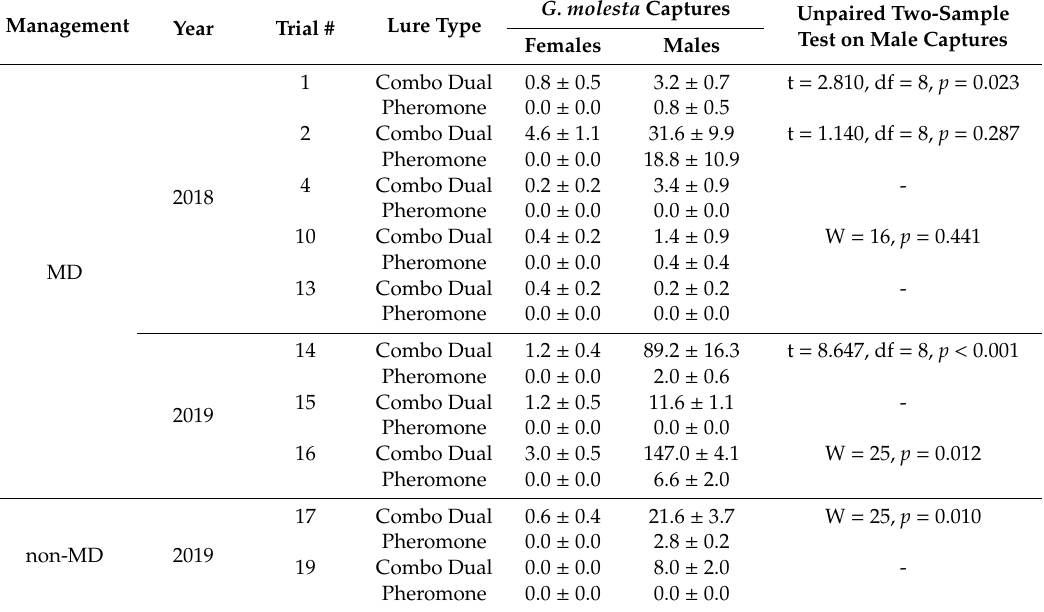
Table 5. Grapholita molesta captures in ten trials of lure comparison conducted in mating disruption (MD)-treated and -not treated peach and nectarine orchards in Italy during early fruit development crop stage in 2018–2019. Mean ( ± SEM) of total moth captures over 6–8 weeks of trial duration. Monitoring traps were either baited with Pherocon ® OFM Combo Dual (Combo Dual) or Pherocon ® OFM L 2 (Pheromone), both Tr é c é Inc.